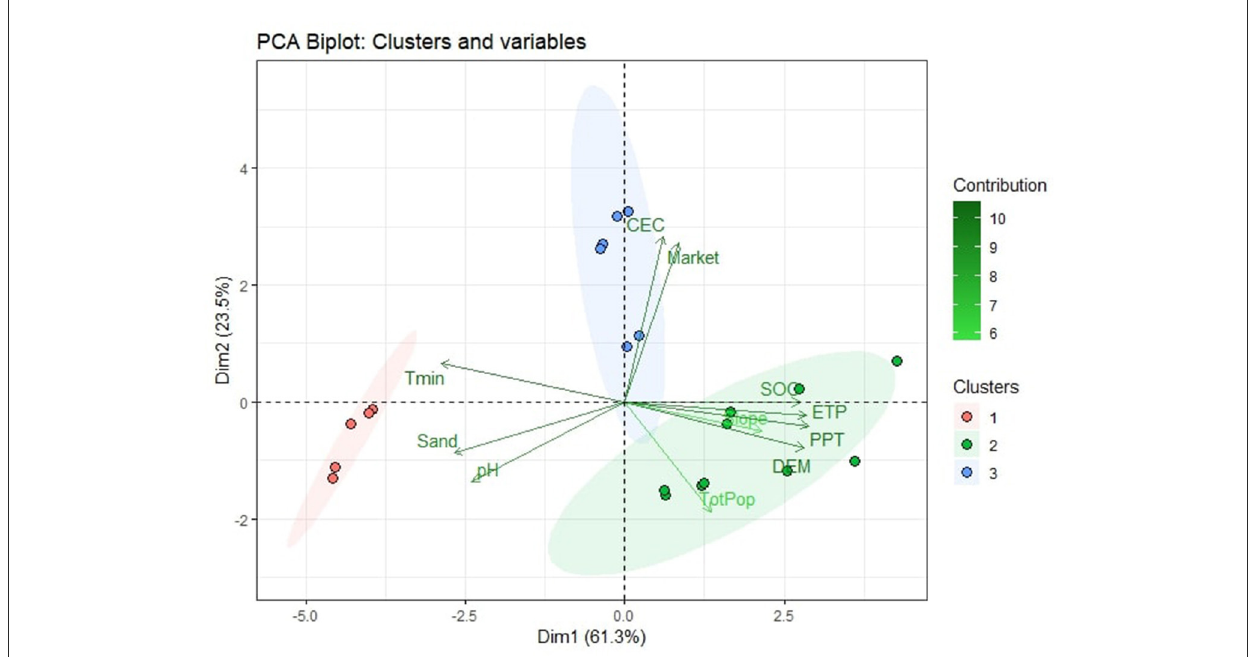
FIGURE4 Characterization of the environmental conditions in the vegetable trials. Cluster 1 represents trials in Matufa village, cluster 2 are Bermi and Seloto and cluster 3 is Galapo. Trials in cluster 1 (Matufa village) and 3 (Galapo) showed the highest median yield (Qty Prod) and net benefit for the African eggplant and tomato, respectively (Figure 5). Therefore, trial plots located in the two best-performing clusters (1 and 3) were selected as the reference sites when delineating the extrapolating suitability maps for the two cultivars.